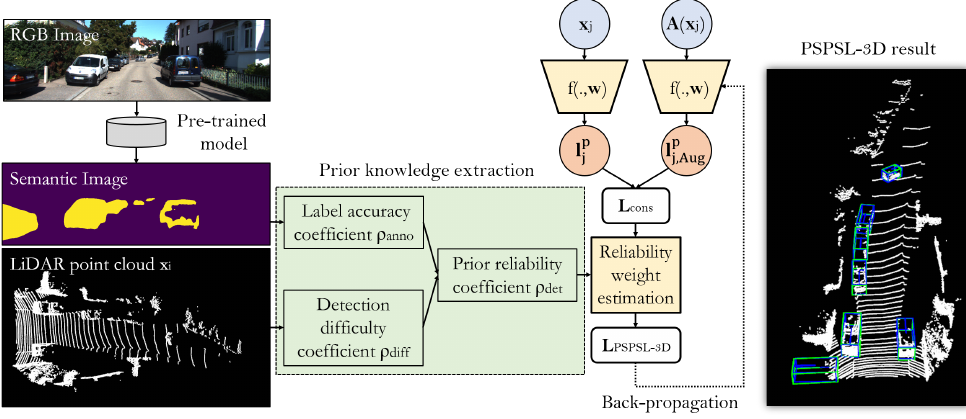
Figure 2. Framework of the proposed PSPSL-3D. It can evaluate the reliability weight of a pseudo label from prior knowledge extracted from the LiDAR point cloud and RGB